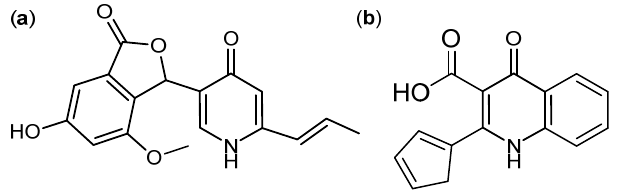
Figure 24. ( a ) Penicidone B and ( b ) Penicinoline.